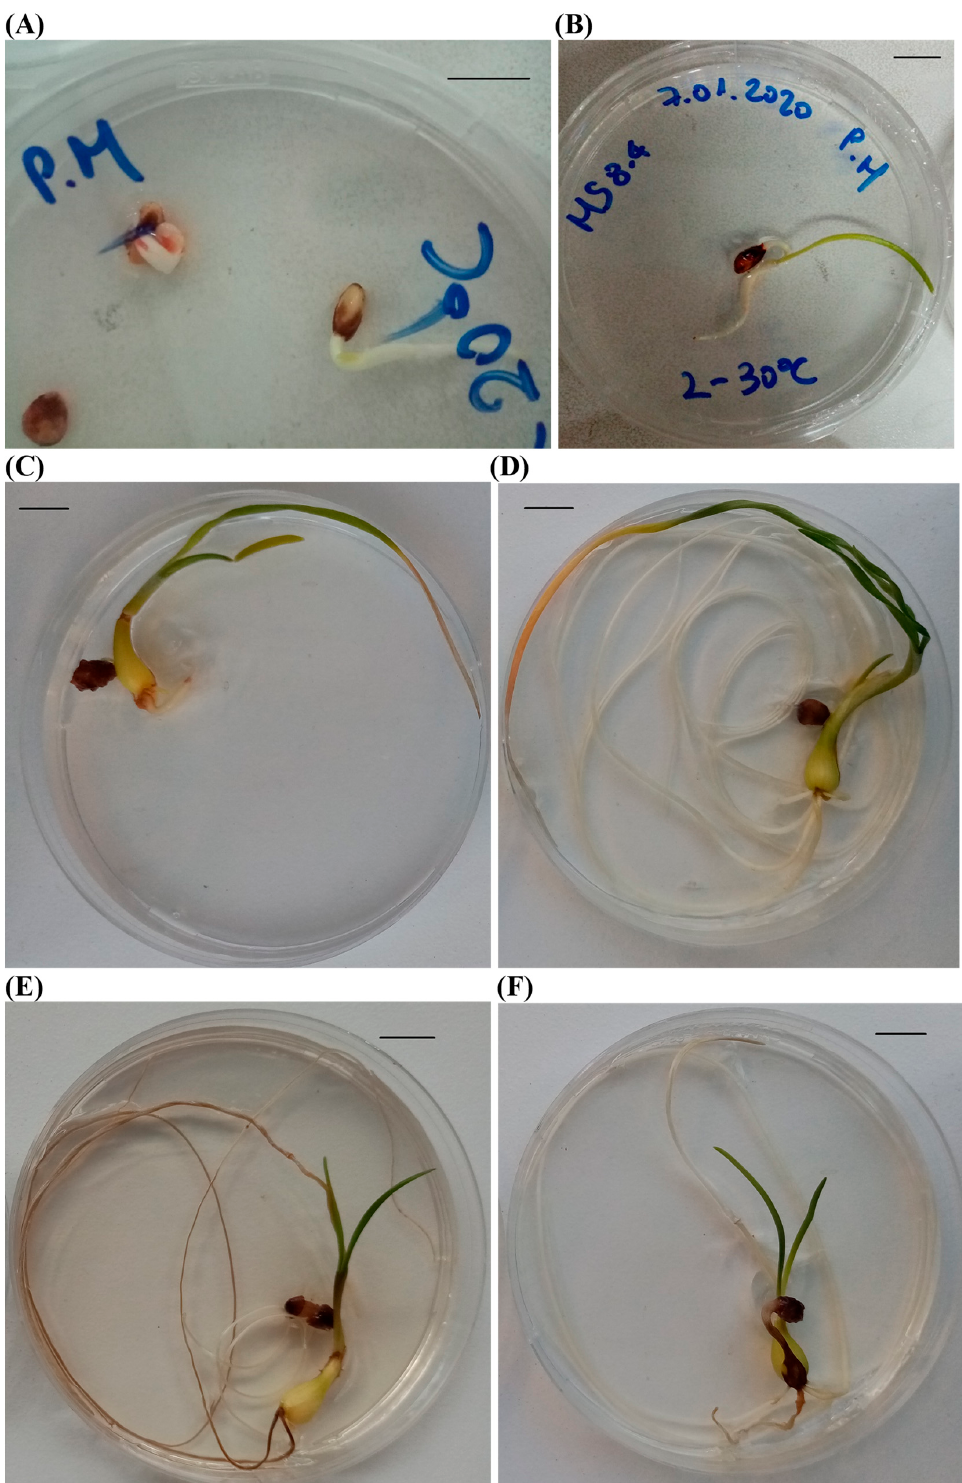
Figure 1. ( A ) In vitro seed germination of Pancratium maritimum at 20 °C after 8 days, ( B ) seedlings at the stage of one leaf—20 days after the establishment of seeds in vitro, ( C ) seedling-bulblet development in culture medium with sucrose 40 g/L at 10 °C after 72 days, ( D ) seedling-bulblet development in culture medium with sucrose 40 g/L at 30 °C after 72 days, ( E ) seedling-bulblet development in culture medium with sucrose 80 g/L at 20 °C after 72 days, ( F ) seedling-bulblet development in culture medium with sucrose 80 g/L at 30 °C after 72 days. Bars = 10 mm.